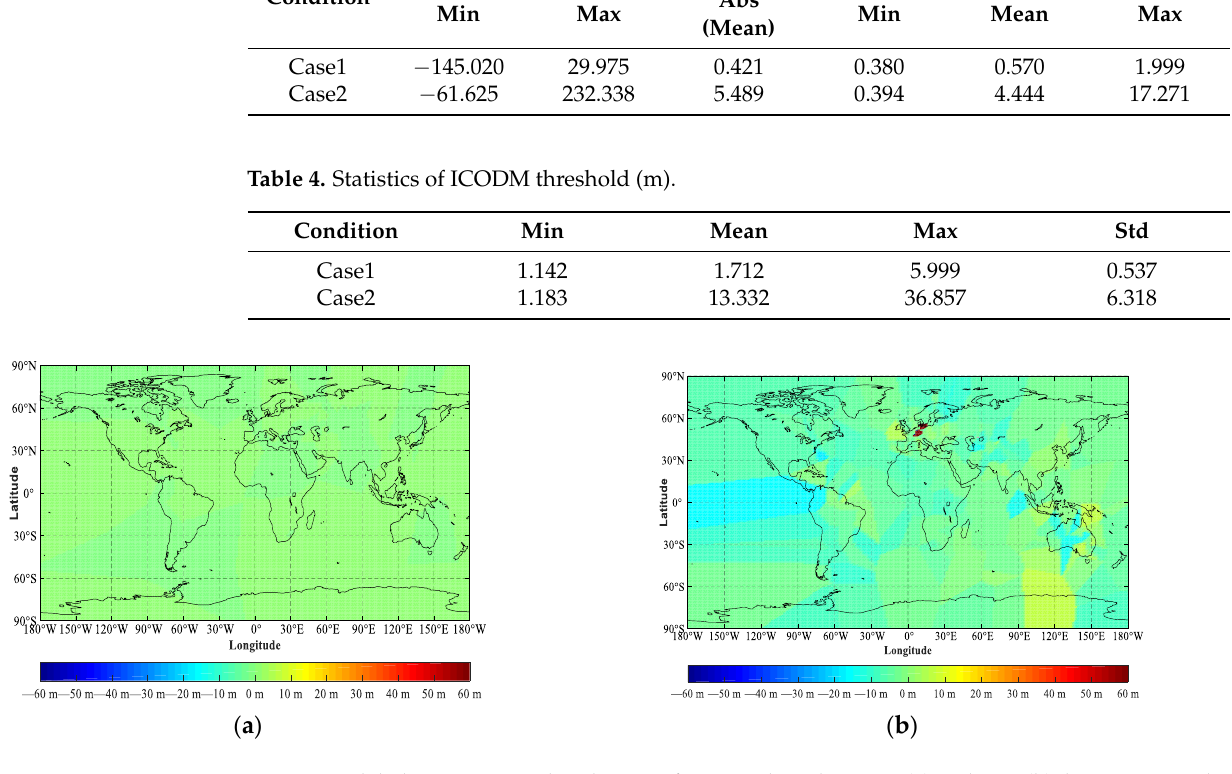
Table 3. Statistics ICODM test statistics and RMSE (m).